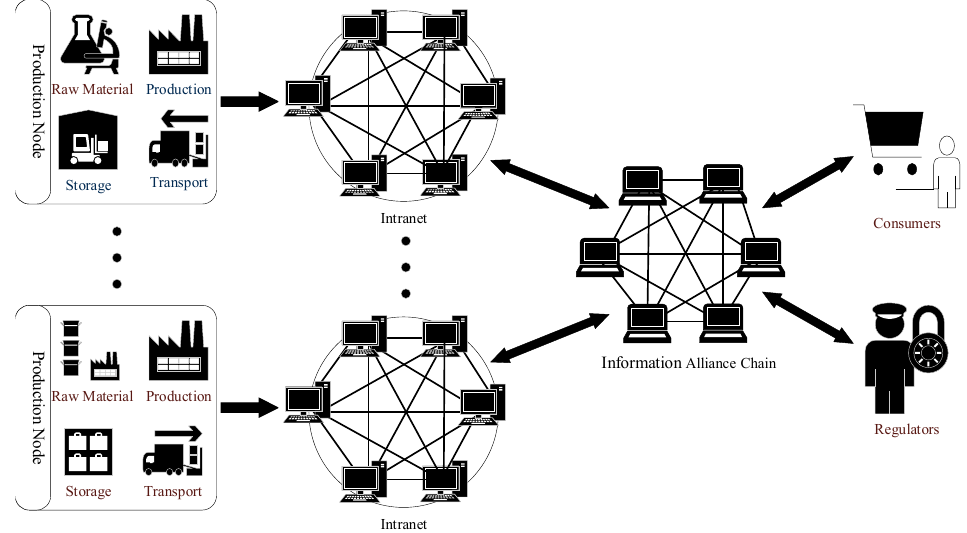
Figure 5. Overall structure of info alliance chain.